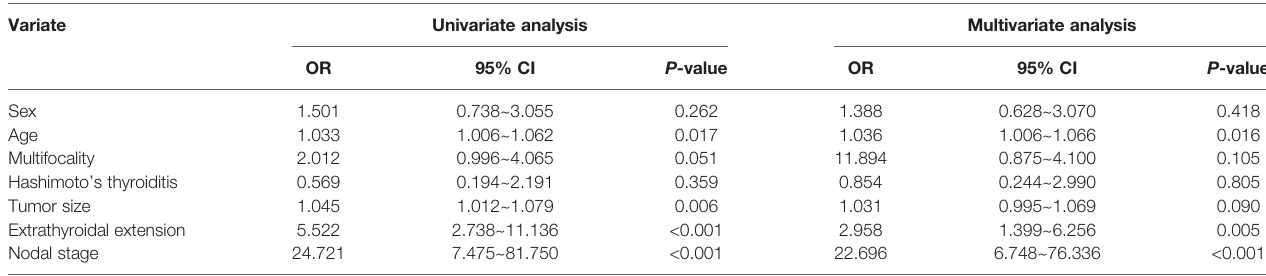
TABLE 3 | Logistic regression analysis of ENE-related risk factors. Variate